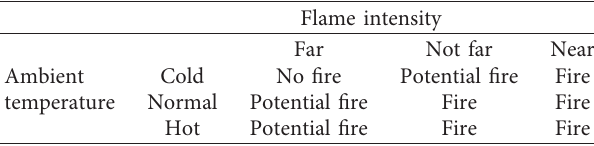
Table 2: Rules for fire status when smoke is medium.